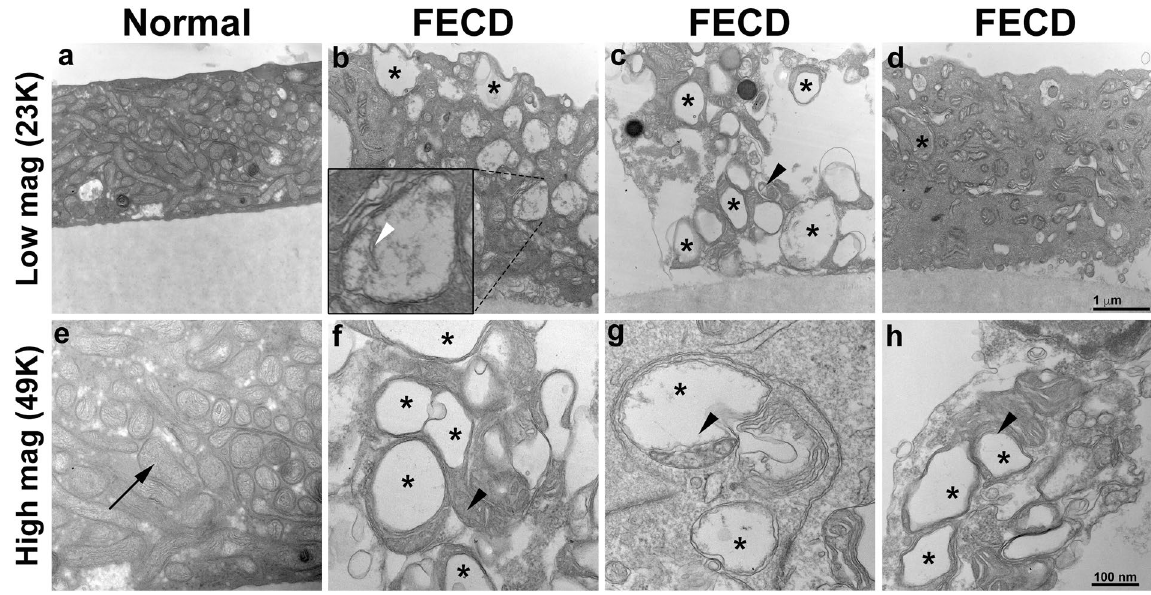
Figure 3. FECD specimens reveal an abundance of autophagic structures and abnormal mitochondria with loss of ETC complex. Transmission electron micrographs of a normal ex vivo specimen ( a , e ) show the presence of high density of normal mitochondria (black arrow) in a corneal endothelial cell. Panels b–d and f–h are representative images of FECD ex vivo specimen that suggest increased number of autophagic structures in the form of vacuoles (black stars). Black arrowheads in panels c , f – h indicate autophagosomes containing mitochondria and white arrowhead in panel ii indicates degraded mitochondrial